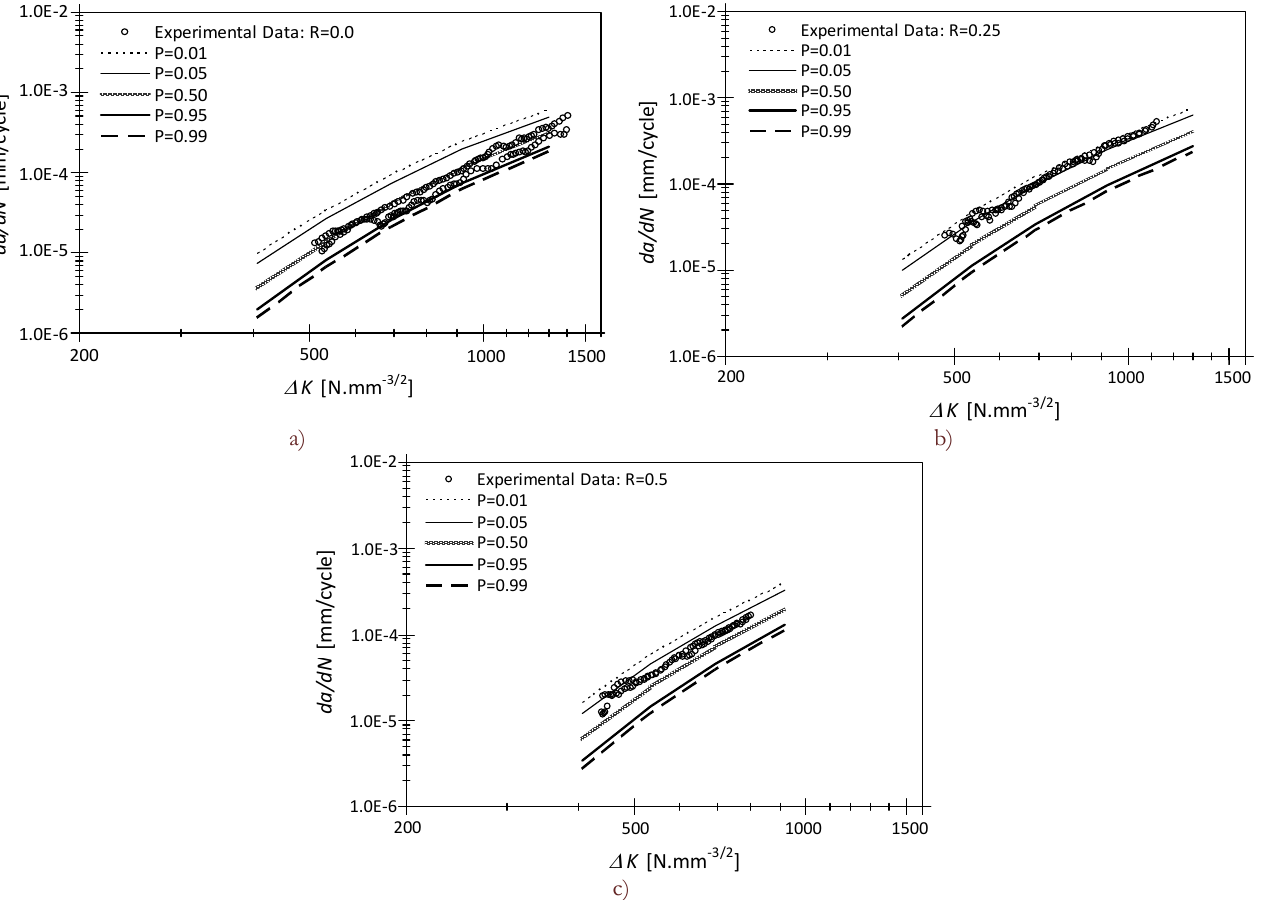
=0; b) R =0.25; c) σ σ